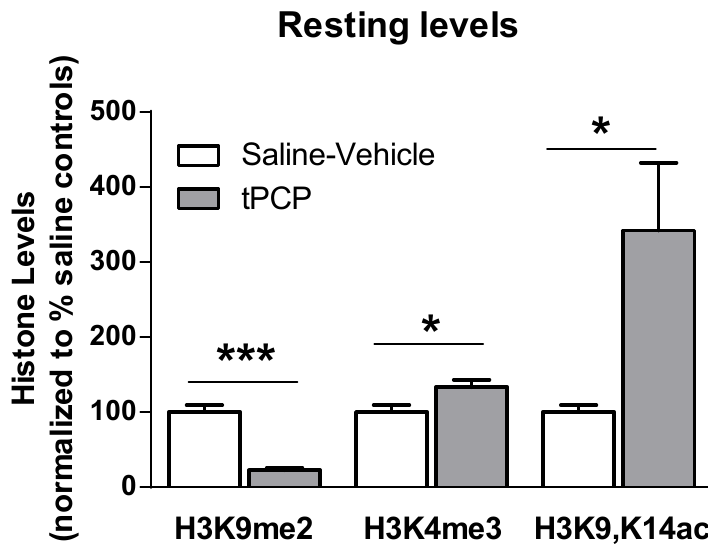
Figure 4 . LSD1 inhibition alters baseline resting histone modification levels in area CA1 of young adults. Animals were given IP injections of 3 mg/kg t-PCP or saline-vehicle and the effect of LSD1 inhibition was assessed on H3K9me2, H3K4me3, and H3K9,K14ac levels in area CA1. Histone H3 modifications were normalized to total histone H3 protein levels. Histone modification levels are presented relative to the percentage of saline-vehicle controls. Group sizes : saline H3K9me2, n = 4; tPCP H3K9me2, n = 4; saline H3K4me3, n = 4; saline H3K9,K14ac, n = 4, tPCP H3K9,K14ac, n = 3. Student’s t-test ; * p < 0.05, error bars represent the